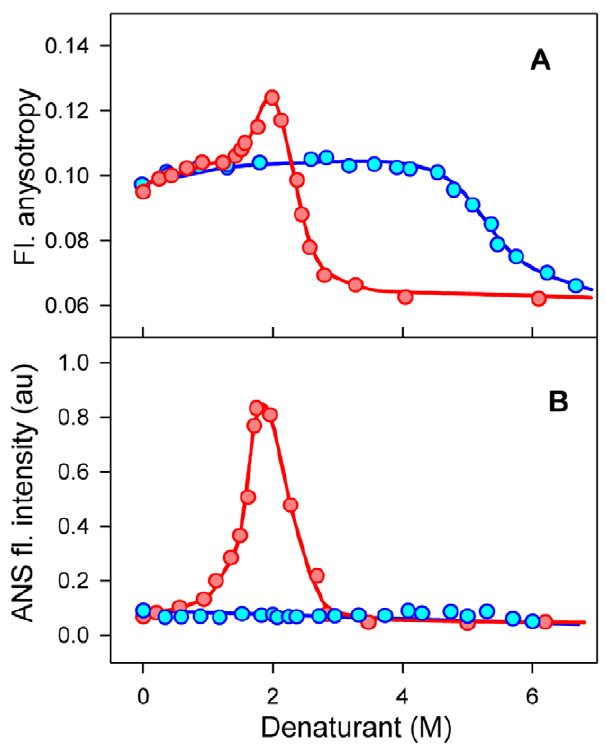
Figure 2. Denaturation of CA II induced by GdnHCl (red symbols) and urea (blue symbols). Panels A and B represent the changes in anisotropy of intrinsic fluorescence and ANS fluorescence intensity, respectively. The protein concentration was 0.15 mg/ml, ANS concentration was 5 ? 10 2 5 M, pH 7.5.